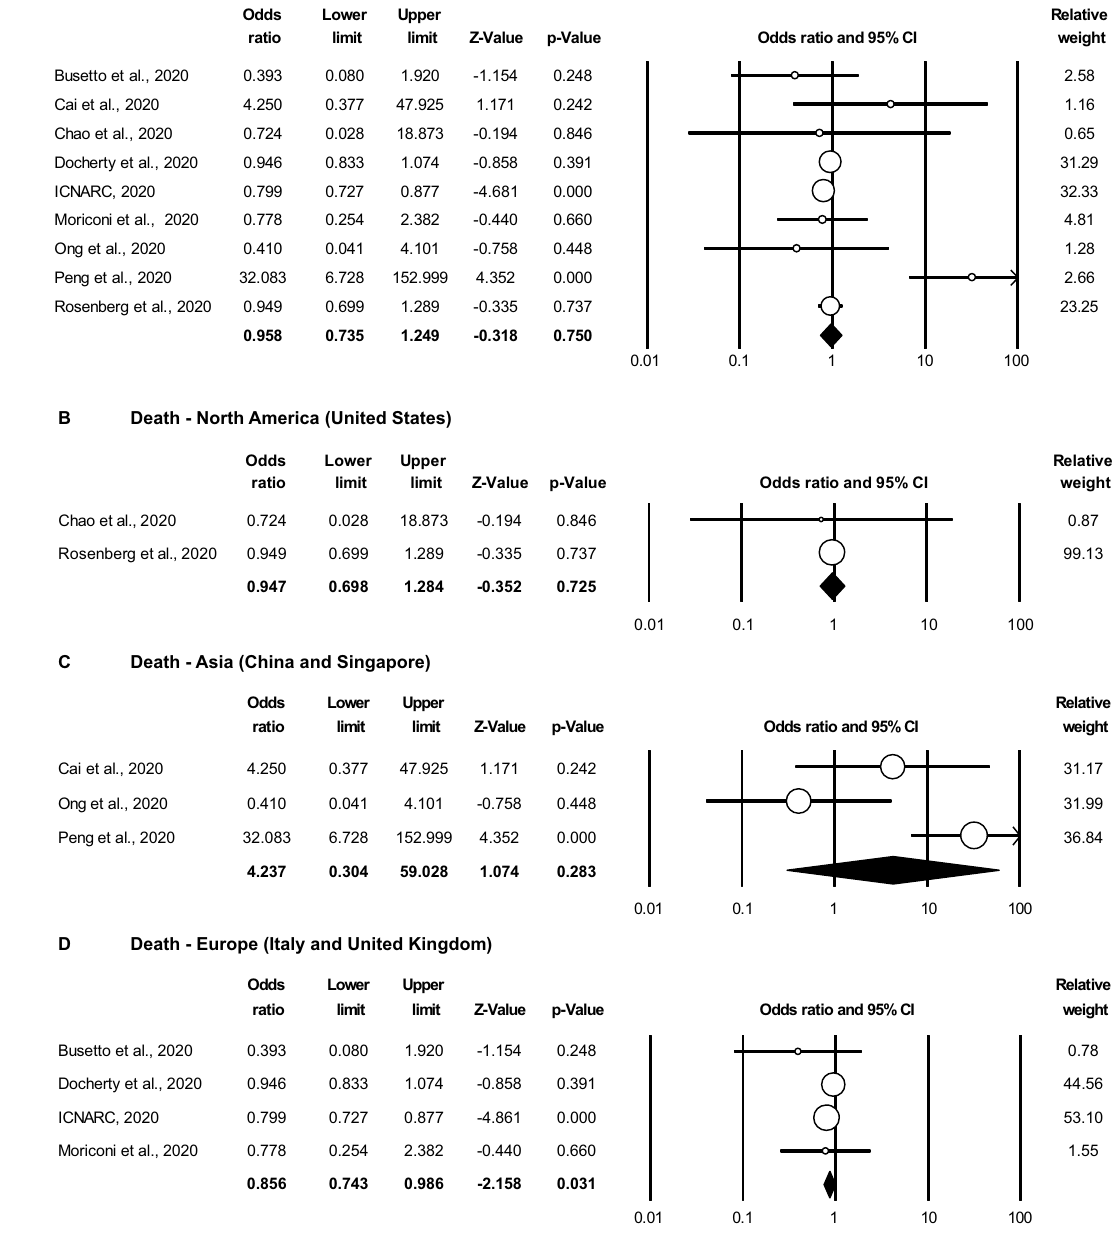
Figure 4. Obesity is not associated with increased COVID-19-associated mortality. Random effects meta- analysis of odds ratios (OR) and 95% confidence intervals (CI) for the likelihood of death in obese vs non-obese COVID-19 patients ( A ) overall (9 studies, n = 20,597 patients and in studies from ( B ) North America (2 studies, n = 1,076), ( C ) Asia (3 studies, n = 586), and ( D ) Europe (4 studies, n = 18,935). Non-obese is defined as the reference